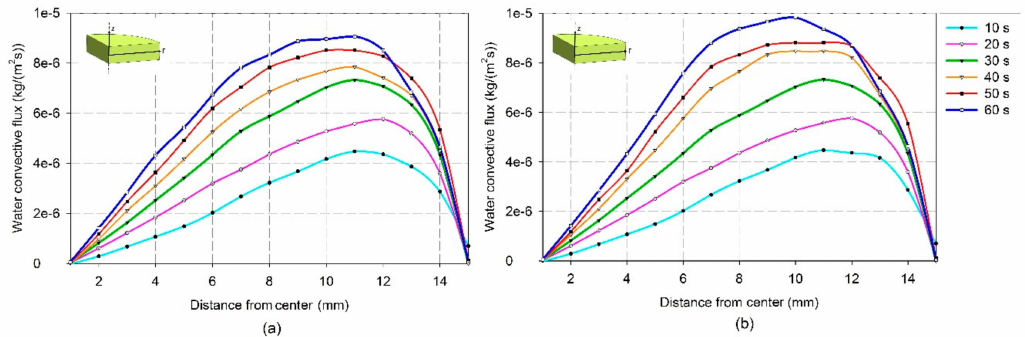
Figure 16. Water flux due to gas pressure of ( a ) unripe bananas, and ( b ) ripe bananas.